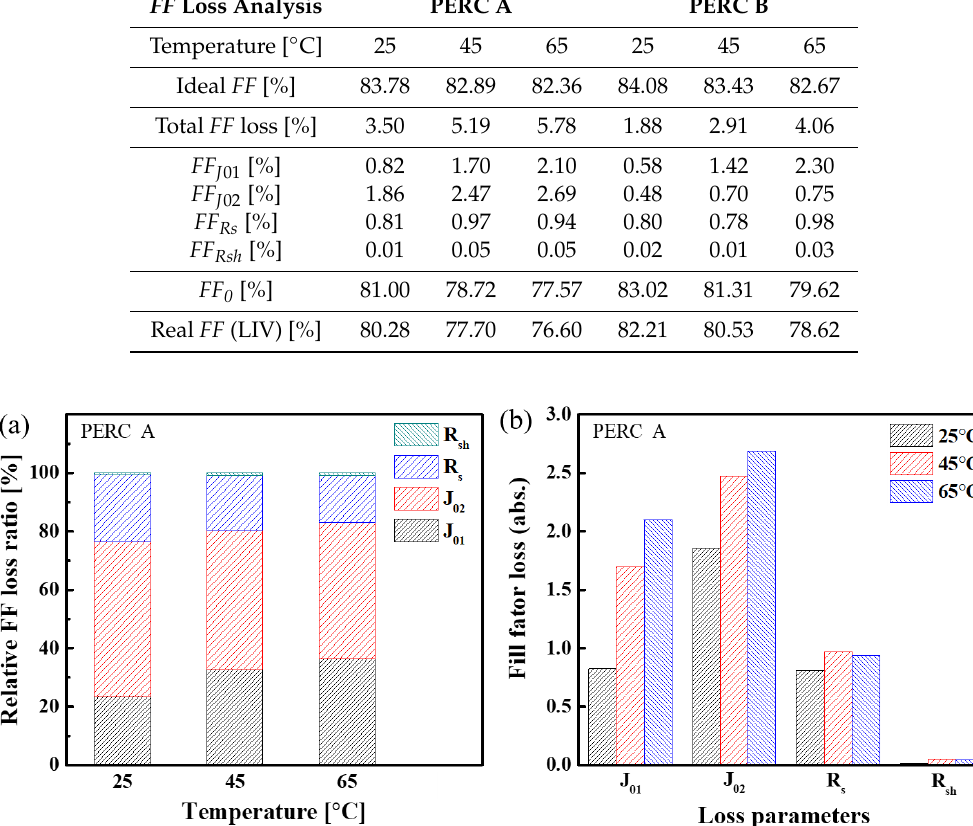
Figure 7. Fitting results of injection dependent-carrier lifetime for the PERC A and B. The expressions for the intrinsic carrier lifetime and bulk lifetime can be expressed as follows. 𝜏 = 𝛥𝑛 𝑅